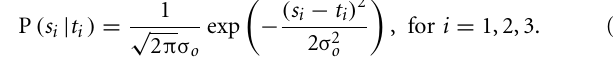
FIGURE 2 | (A) A temporal pattern and its observation.The horizontal axis is time. Each solid vertical line indicates an actual sound timing t i , and each dashed vertical line indicates its observed timing s i . Each observation is made on the basis of an independent identical distribution. (B) Likelihood function of ( T 1 , T 2 ) given observed values of S 1 = 100ms and S 2 = 140ms (indicated as “ + ”). Intensity indicates the degree of likelihood. (C) Prior distribution of ( T 1 , T 2 ) with intensity on a logarithmic scale of the probability, illustrating that the prior takes a high value near